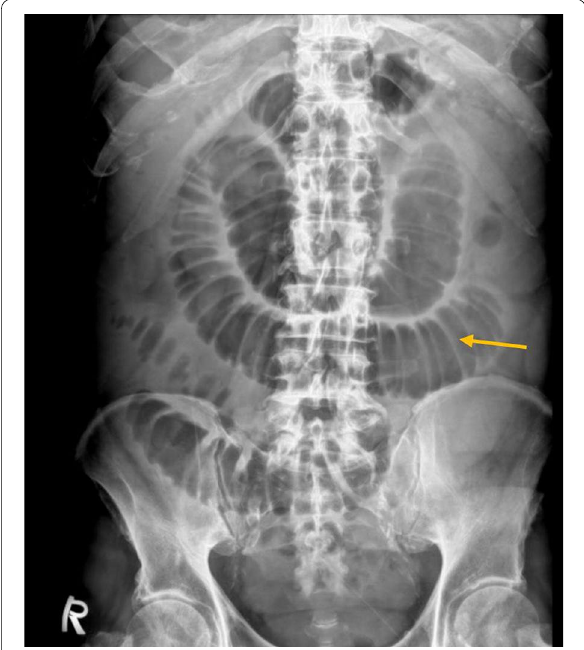
Fig. 1 Abdominal radiograph in supine position showing small bowel dilatation (yellow arrow) with non-dilated large bowels